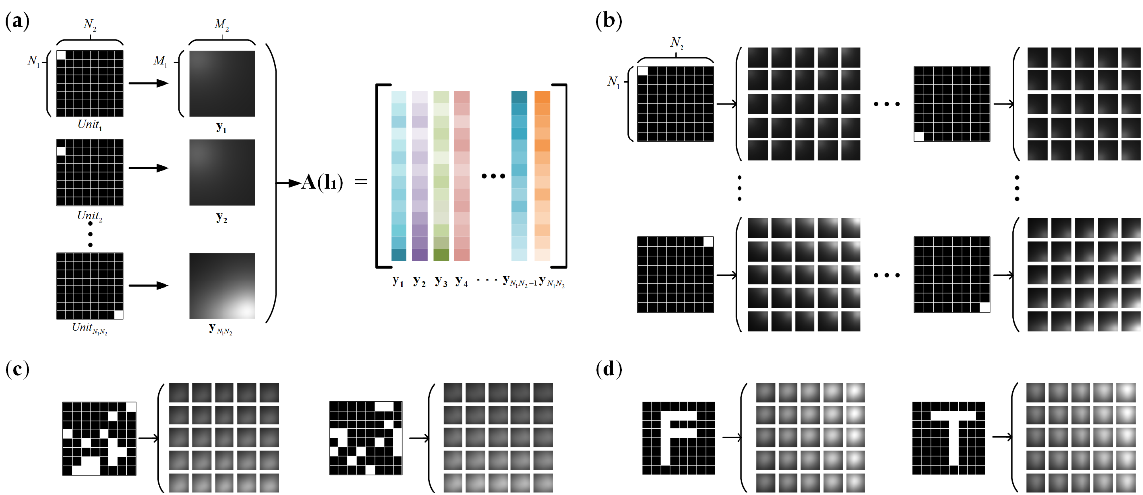
Figure 4. Simulated projections: ( a ) the hidden target unit and its projected image of the laser position l 1 ; ( b ) the laser scanned a 5 × 5 array of the positions, and the corresponding projected images of the target units were generated on the intermediate surface; ( c ) two examples of randomly superimposed target units and their corresponding projected images; ( d ) two examples of meaningful test objects and their projected images.